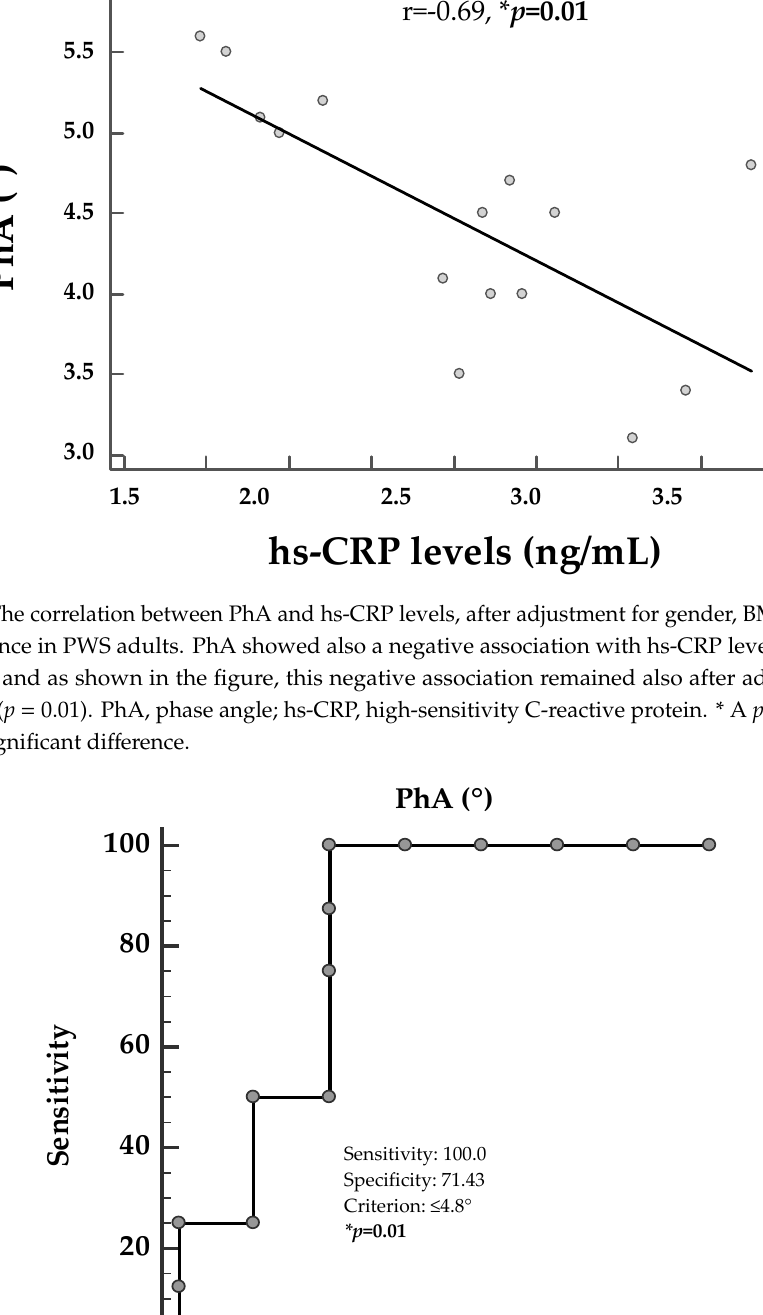
Figure 4. ROC for value of PhA predictive of the highest hs-CRP levels above the median value (3.68 ng/mL). At the ROC analysis, the threshold value of PhA predicting the highest hs-CRP levels (above the median value 3.68 ng/mL) was found at PhA ≤4.8° ( p = 0.01; AUC, 0.82; standard error, 0.12; 95% CI, 0.58 to 1.00). PhA , phase angle; hs-CRP , high-sensitivity C-reactive protein. *A p- value in bold type denotes a significant difference ( p < 0.05).